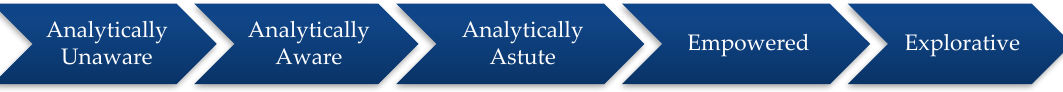
Figure 10. SAS Analytics Maturity Scorecard—stages of analytics maturity. Source: own elaboration based on [34].